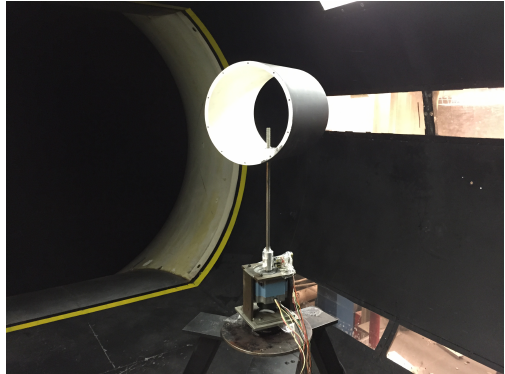
Figure 3. Example of a continuously rotating load measurement setup. A slender cylindrical rod is used as support, mounted on stepper motor that is fixed to a load